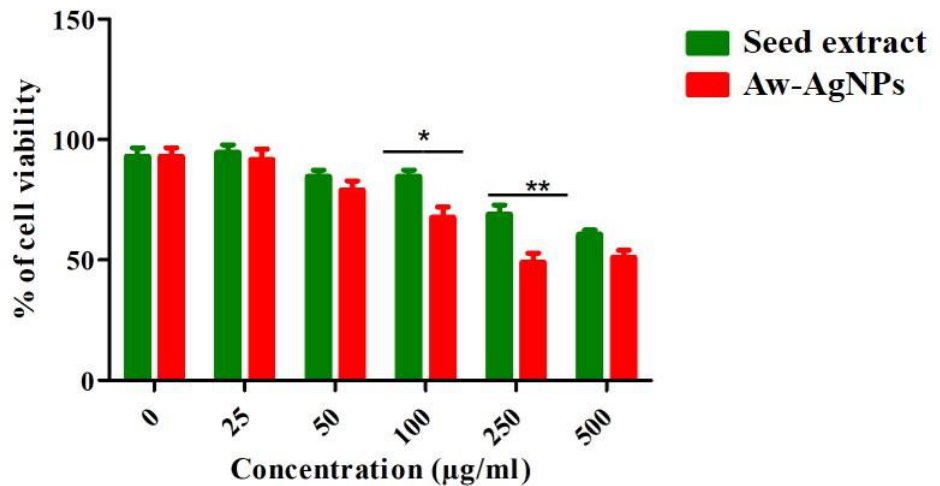
Figure 8. MTT assay results confirming the in vitro cytotoxicity of Aw–AgNPs against HCC 712 human breast cancer cell lines. * Denotes significant difference of control with test samples at p < 0.05 and ** p < 0.01.